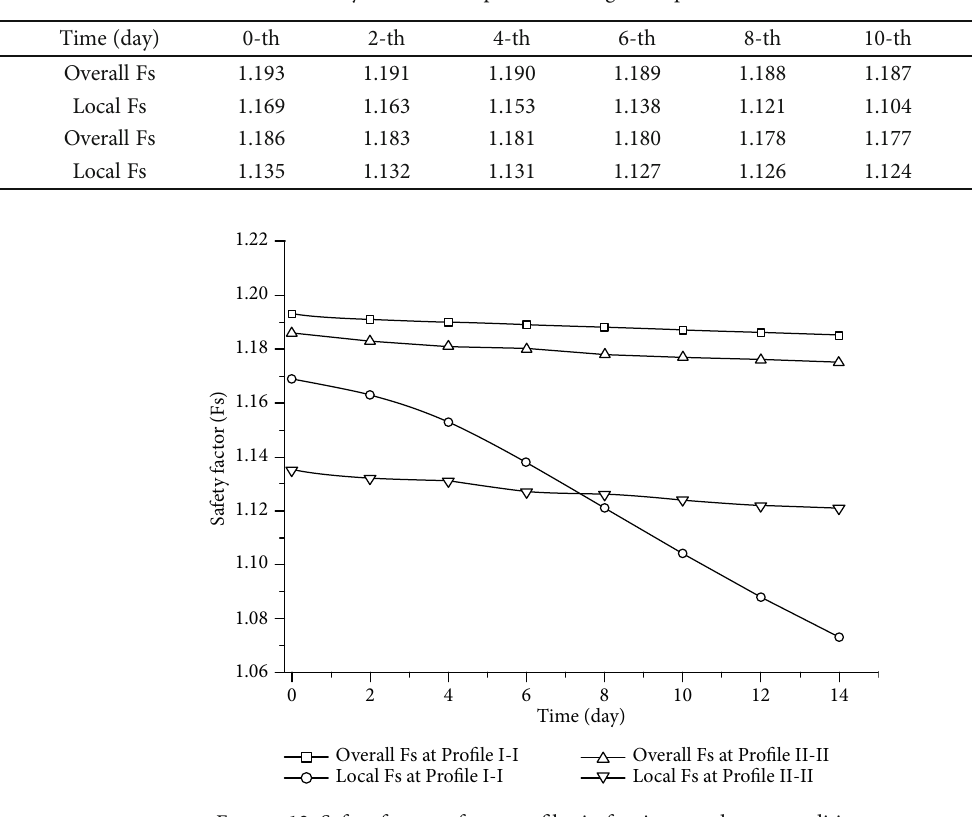
Figure 12: Safety factors of two pro fi les in fast impoundment condition.